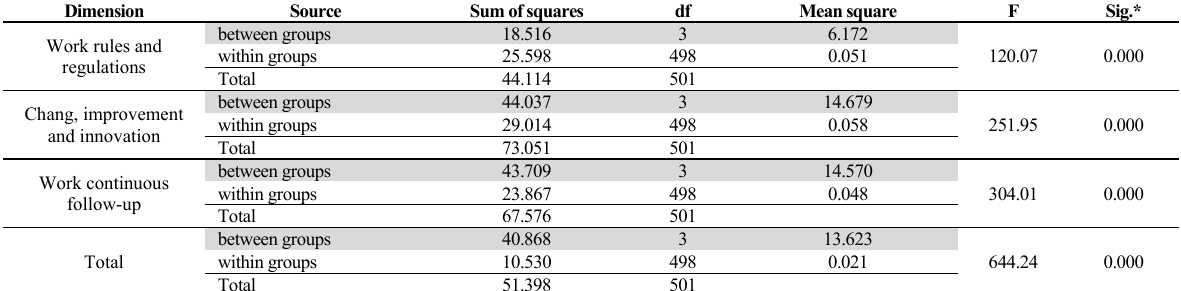
Results of ANOVA for difference in employee responses due to work experience Dimension Source Sum of squares df Mean square F